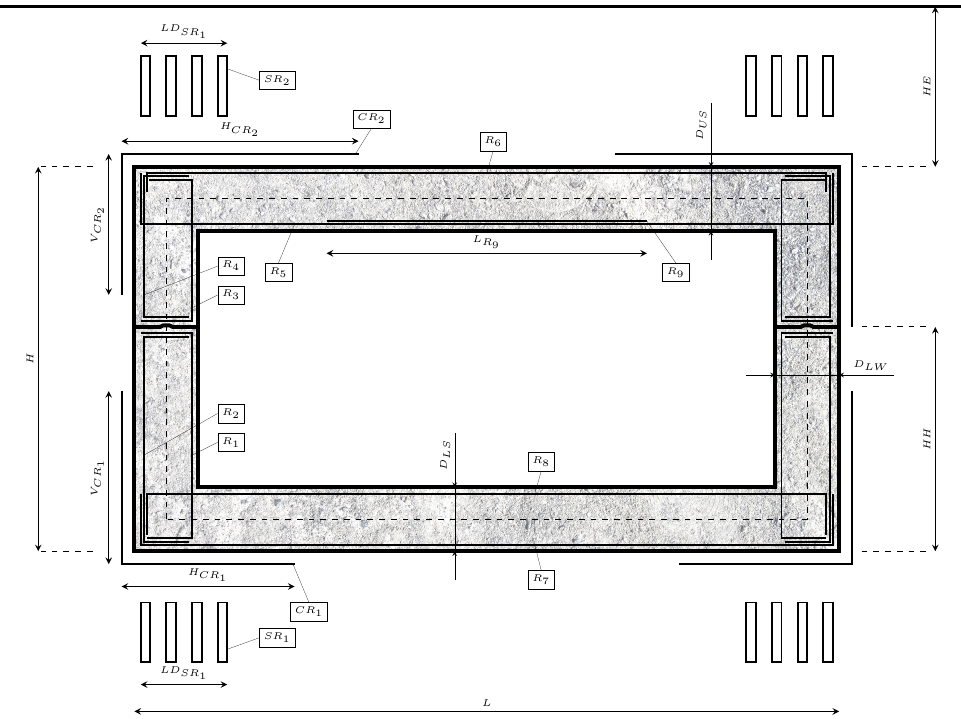
Figure 1. Set of variables of the RMHF considered in the optimization